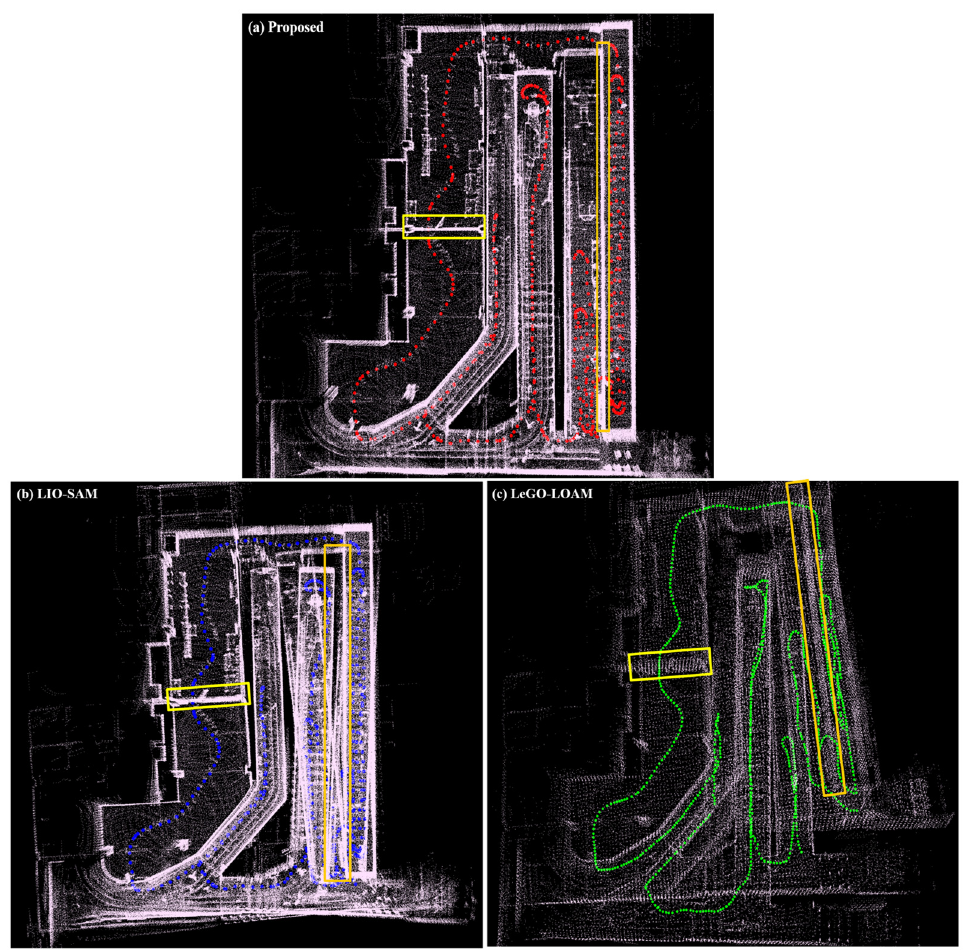
Figure 9. Comparison of mapping results between the proposed method and other methods. ( a – c ) Mapping results by the proposed method, LIO-SAM and LeGO-LOAM, respectively.